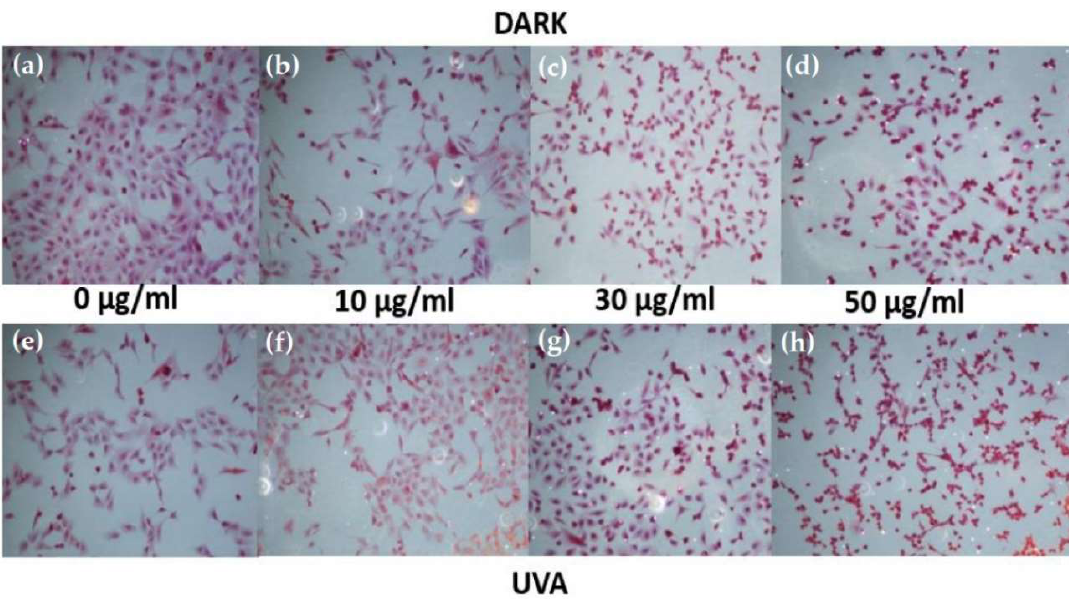
Figure 4. Optical microscopy images of hematoxylin and eosin staining of MCF7 cells after 10 min of exposure to: ( a ) 0, ( b ) 10, ( c ) 30, and ( d ) 50 µg/mL of P25 carried in darkness and at the same concentrations: ( e ) 0, ( f ) 10, ( g ) 30, and ( h ) 50 µg/mL under UVA/vis irradiation.